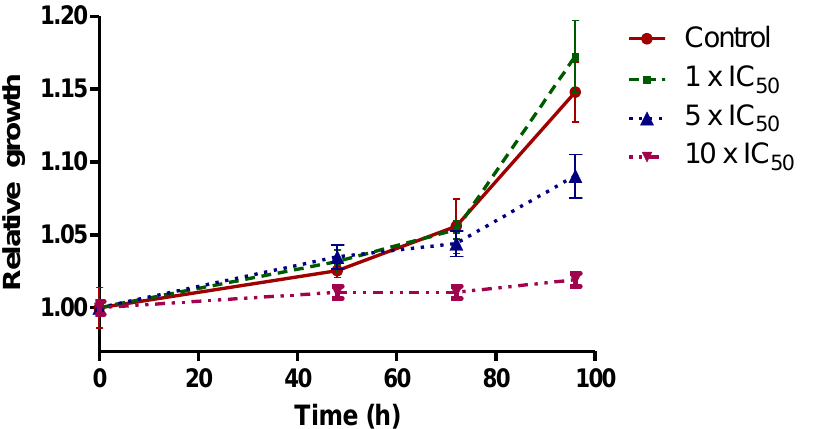
Figure 5. Recovery assays in fresh culture medium after incubation of the parasites with the [V V O(IN-2H)(L2-H)] complex for 24 h. Each experiment was performed in triplicate and the mean and standard deviation is represented for each point.